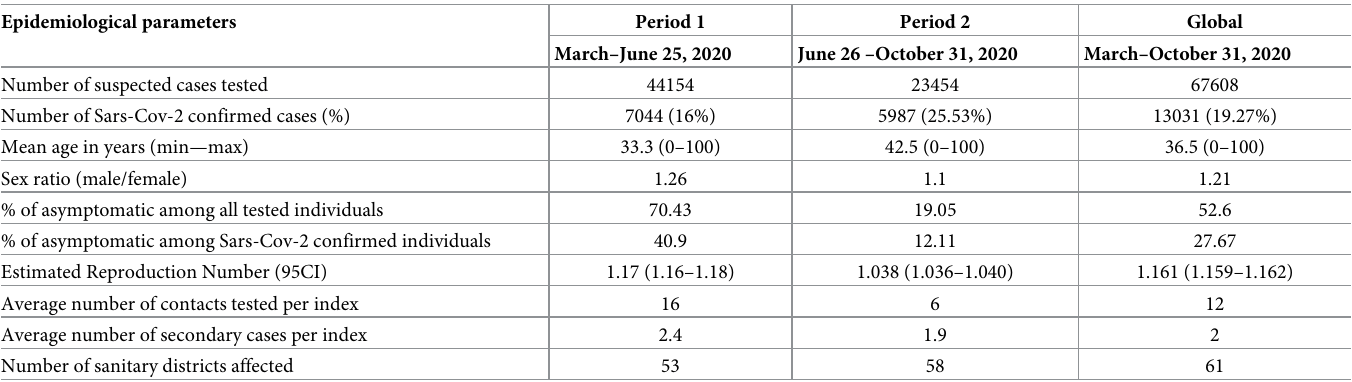
Fig 6. Evolution of the reproduction number across time. Y-axis gives the estimated reproduction number and X-axis the dates. The curve in solid line shows the dynamic of reproduction number. The shaded region around the curve represents the 95% confidence interval. Vertical arrows indicate official dates of the intervention measures taken the Senegalese government. https://doi.org/10.1371/journal.pone.0274783.g006 Table 4. Epidemiological parameters comparison according to different